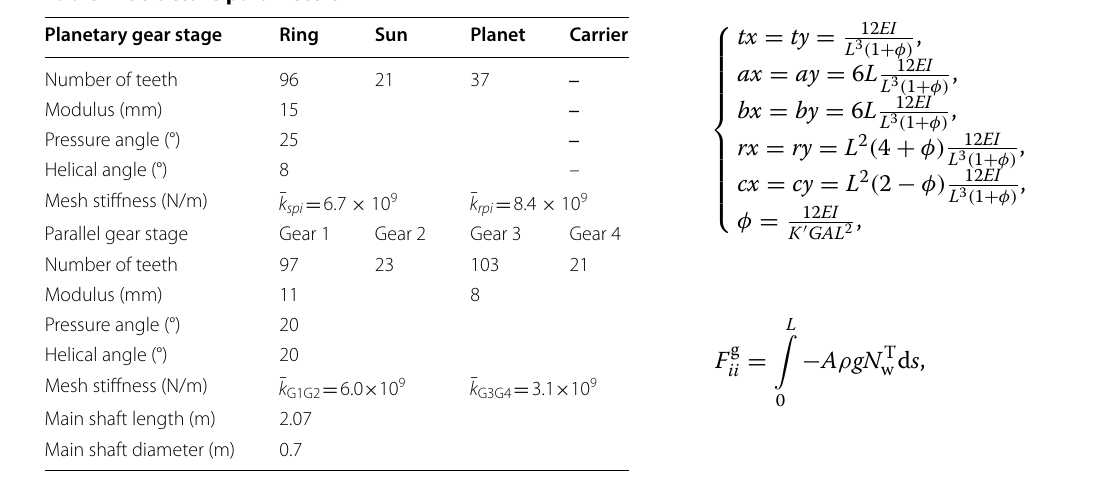
Table 1 Structure